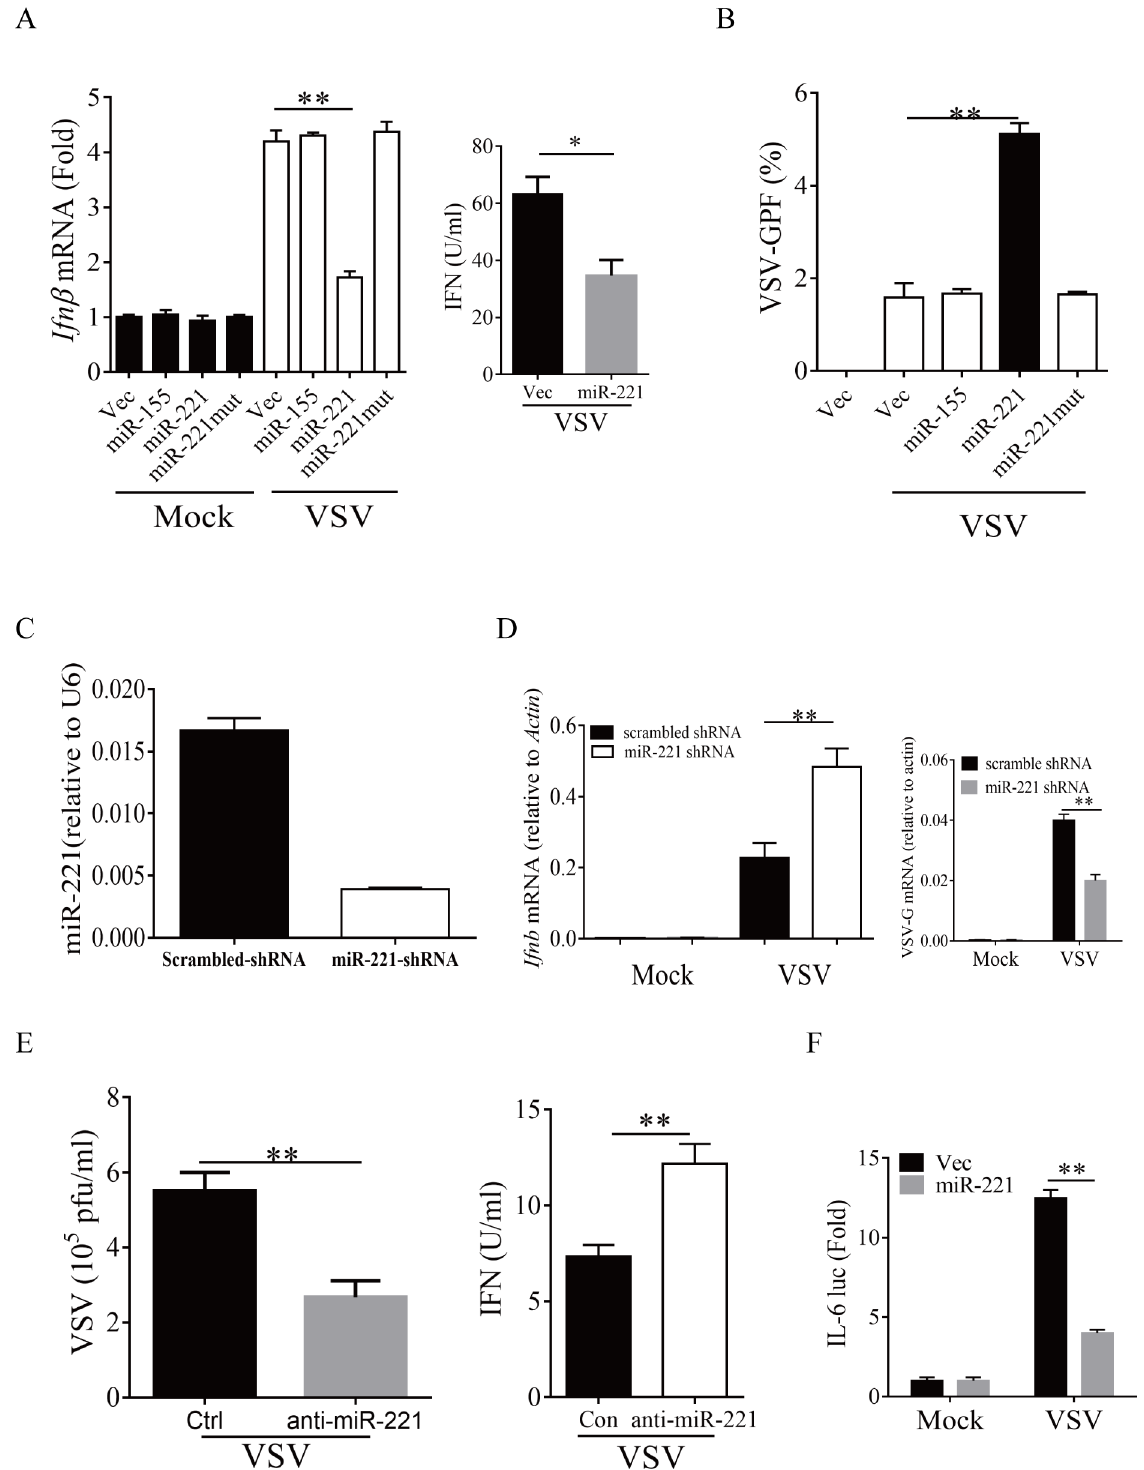
Fig 3. miR-221 negatively regulates innate anti-viral response. (A) HEK 293T cells were transfected with the indicated plasmids (the miR- 221mut plasmid is derived from miR-221 plasmid by deleting 10 core nucleotides). 12 hours later, the cells were infected with VSV. 24 hours later IFN β mRNA was measured by qPCR, supernatant from selected groups were subjected for ELISA. and the viral load (B) was analyzed by FACS. (C) HEK 293T cells were transfected with scrambled or miR-221 shRNA. 48 hours later, miR-221 transcripts were measured by q-